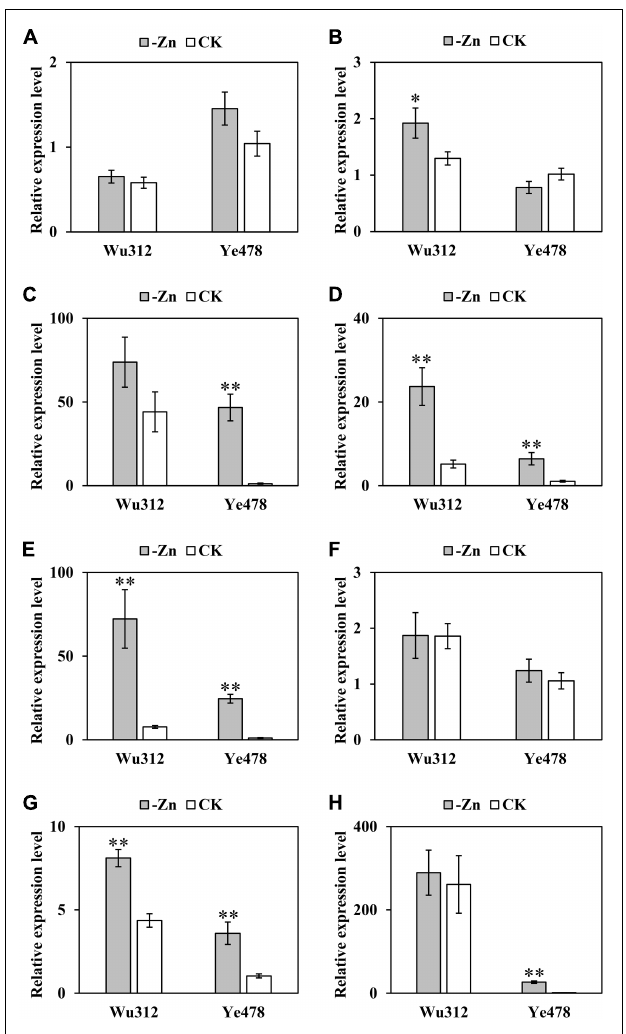
FIGURE 8 | Expression of eight ZIP genes in maize. Relative expression levels of eight ZmZIPs ( ZmZIP1- ZmZIP8 ) in the roots of Wu312 and Ye478 grown hydroponically in a mixed-crop system for 21 days after transplanting in the -Zn (0.3 µ mol L − 1 Zn-EDTA) and CK (10 µ mol L − 1 Zn-EDTA) treatment. (A–H) show the relative expression levels of ZmZIP1- ZmZIP8 , respectively. ∗ and ∗∗ indicate the significant differences between the -Zn and CK treatments at P < 0.05 and P < 0.01,